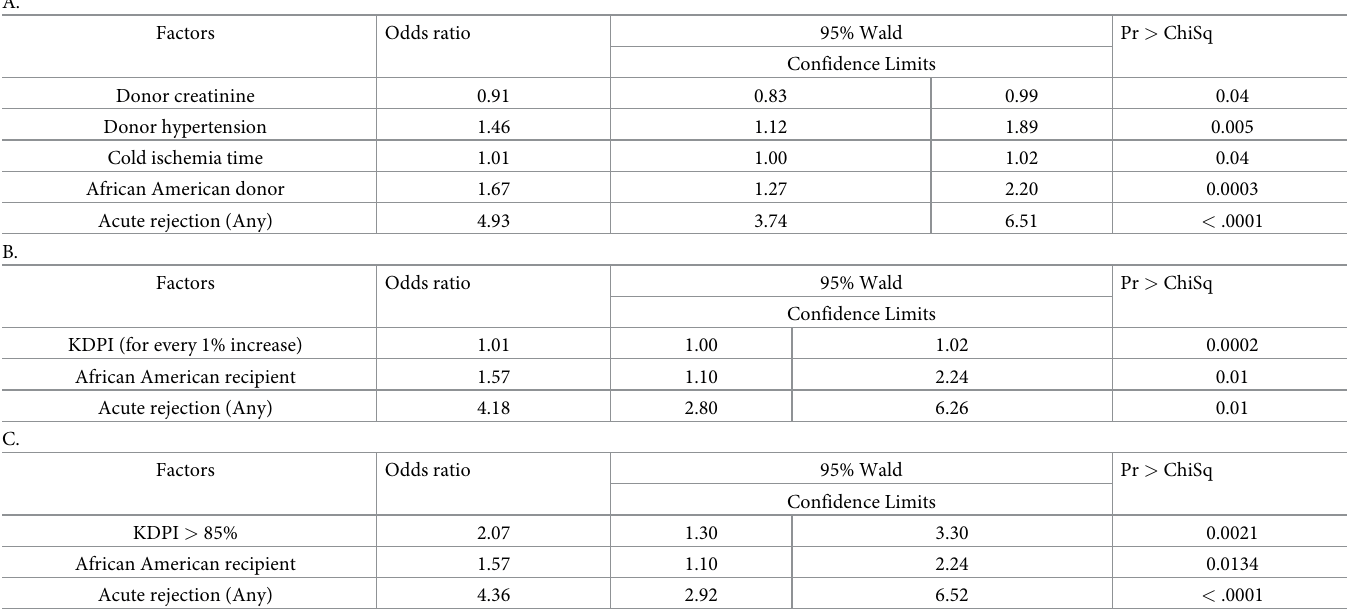
Table 4. Multivariable logistic regression models predicting the odds of graft failure in the AKI donor KTs. A. Including all significant predictors from Table 3 except KDPI. B. Adding KDPI and removing the variables included in the calculation of KDPI to avoid collinearity. C. Adding KDPI ( > 85%) and removing the variables included in the calculation of KDPI to avoid